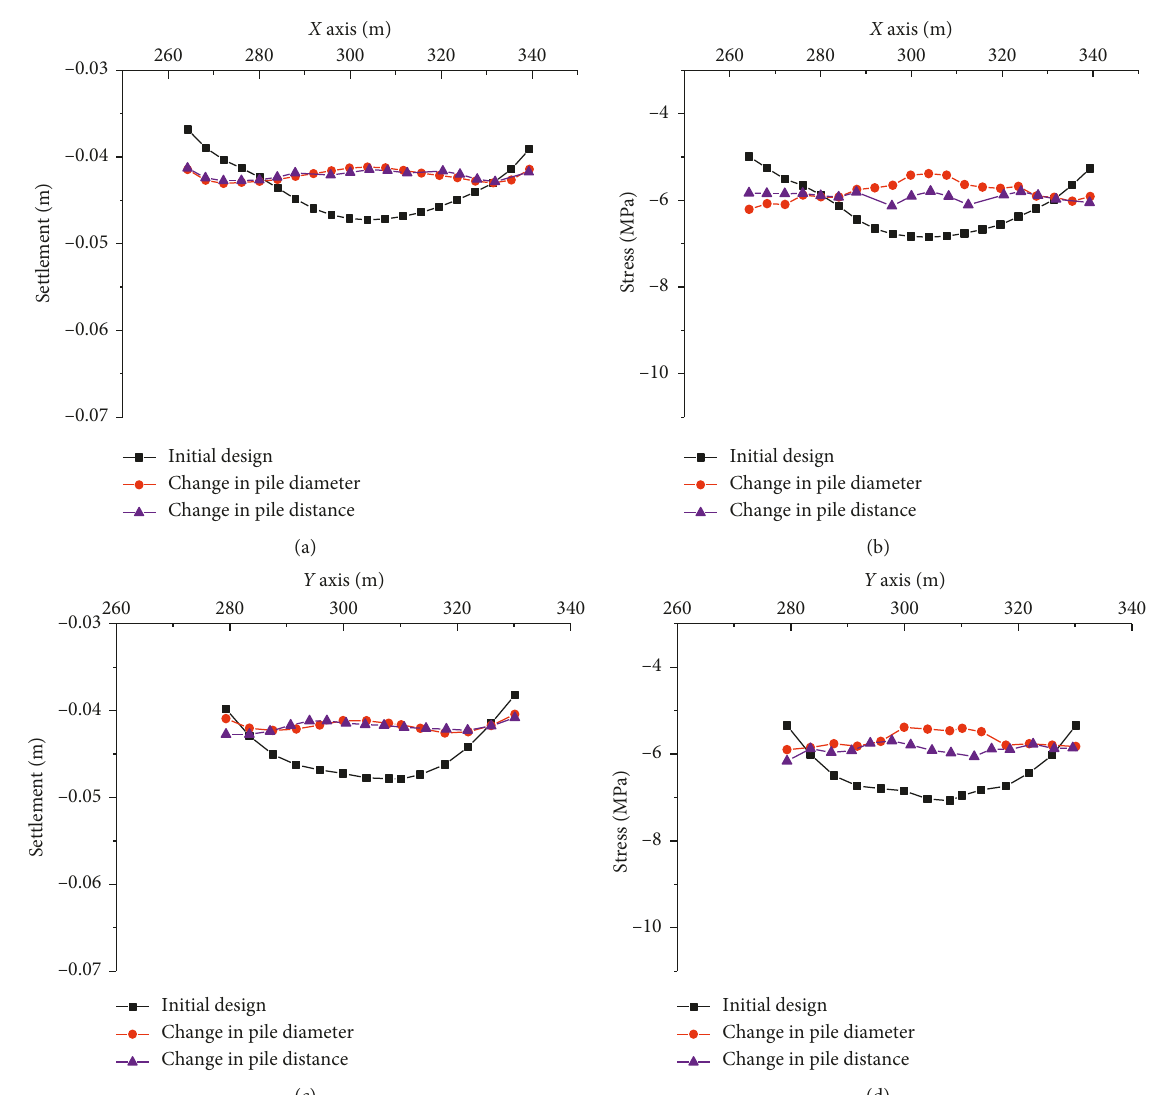
Figure 10: Comparison of the results of the initial design and optimized design: settlement distributions on top of the piles along (a) section A-A and (c) section B-B; stress distributions on top of the piles along (b) section A-A and (d) section